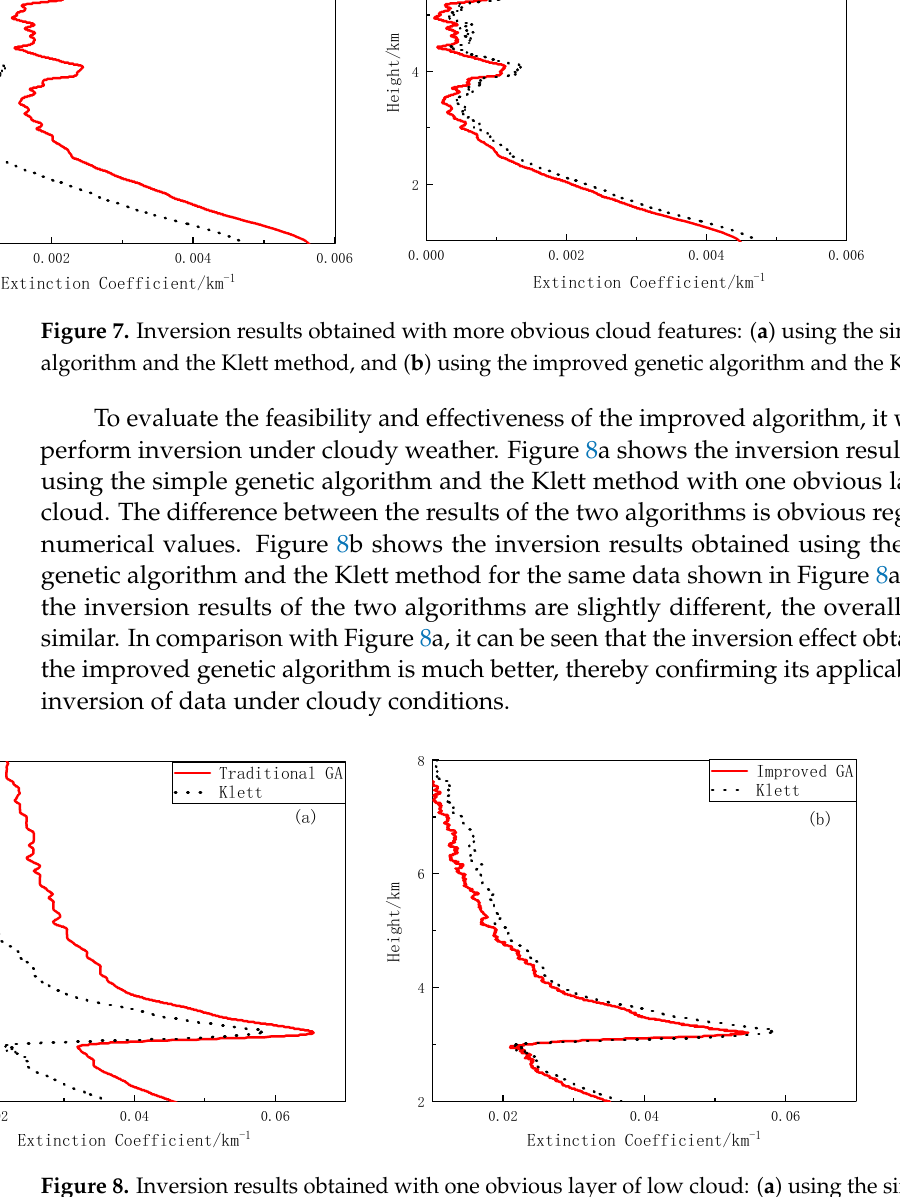
Figure 6. Inversion results obtained under conditions with thin cloud: ( a ) using the simple genetic algorithm and the Klett method, ( b ) using the improved genetic algorithm and the Klett method.